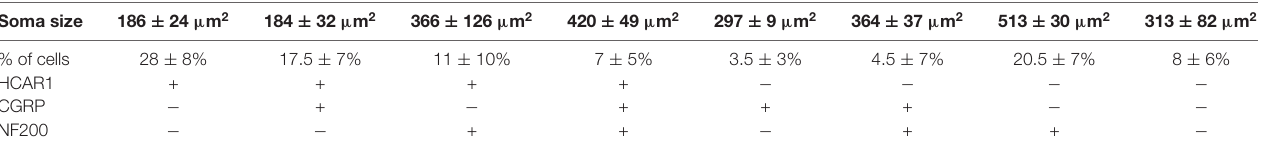
TABLE 4 | Presence of HCAR1-like immunoreactivity in dorsal root ganglia. Soma size